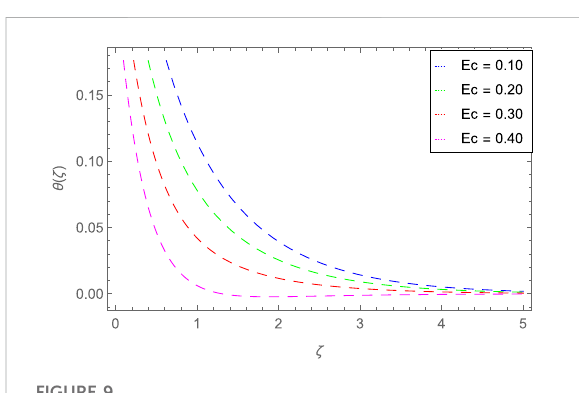
FIGURE 9 Role of the heat transfer pro fi le and parameter.